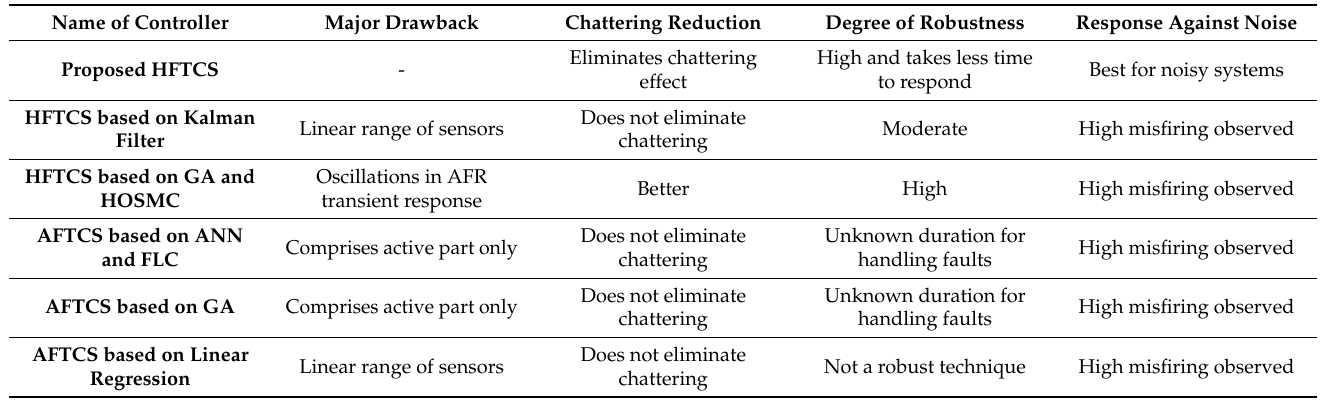
Table 4. Comparison of suggested approach with previous works